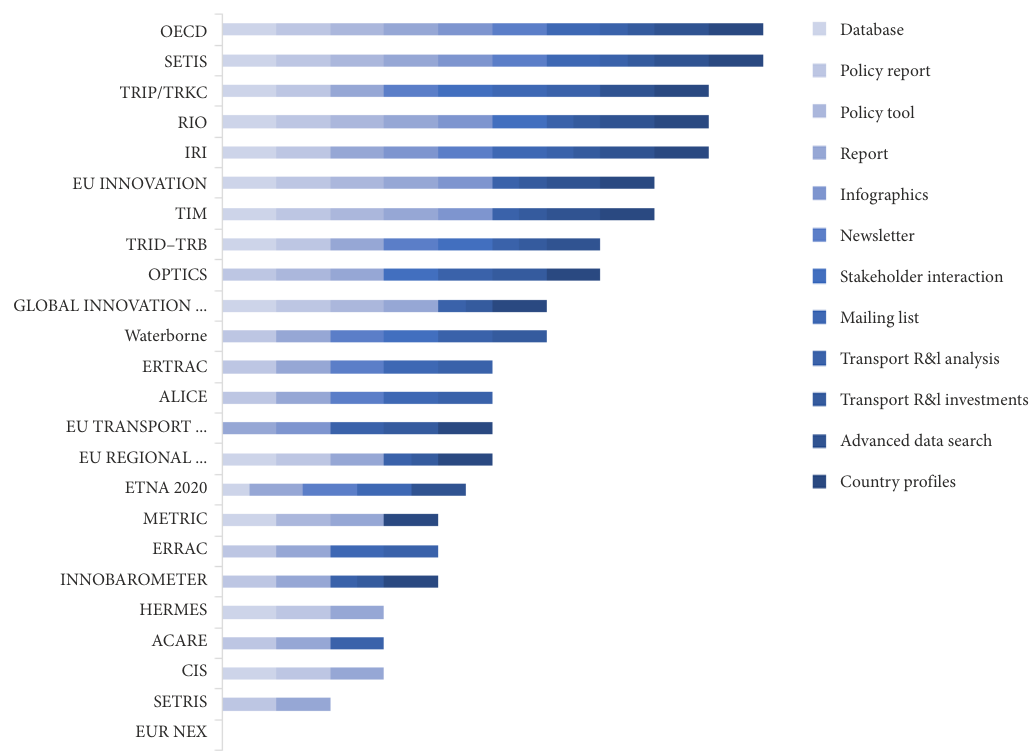
Figure 2. Principal R&I platforms and databases (Tsakalidis et al.